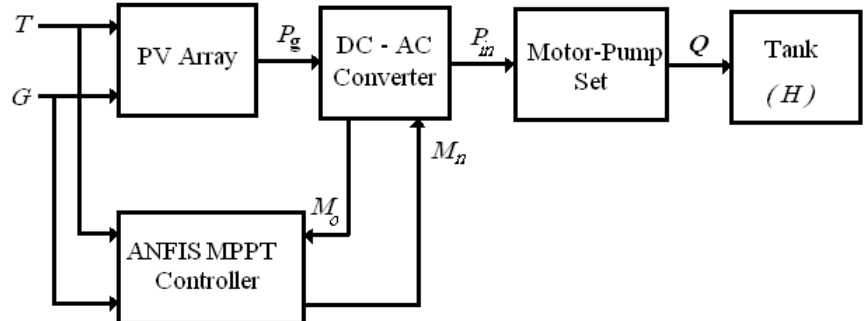
Figure 5. Block diagram of the proposed simulated